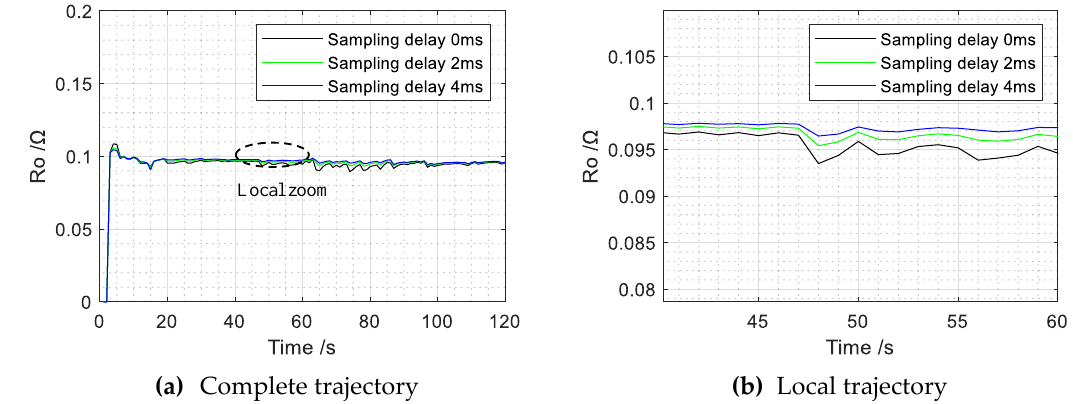
Figure 9. The trajectories of estimated internal resistance with positive sampling delays.